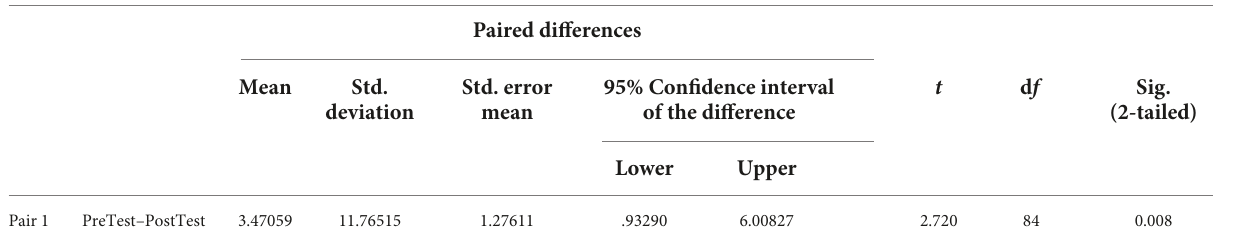
TABLE 2 Paired sample T -test of pre- and post-test scores of